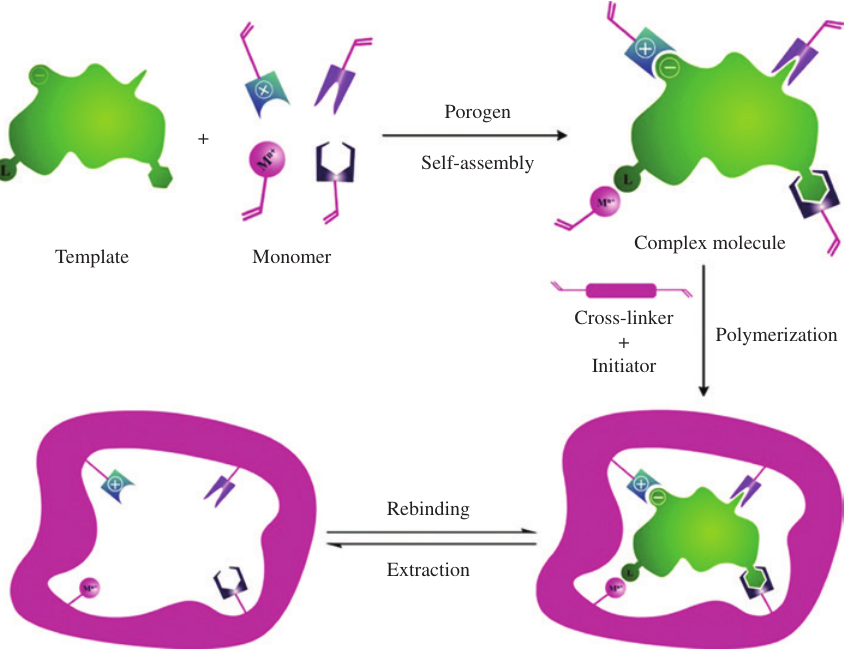
Figure 2: Schematic representation of the molecular imprinting process. This image was reproduced from Hu et al. (2013) with permission from